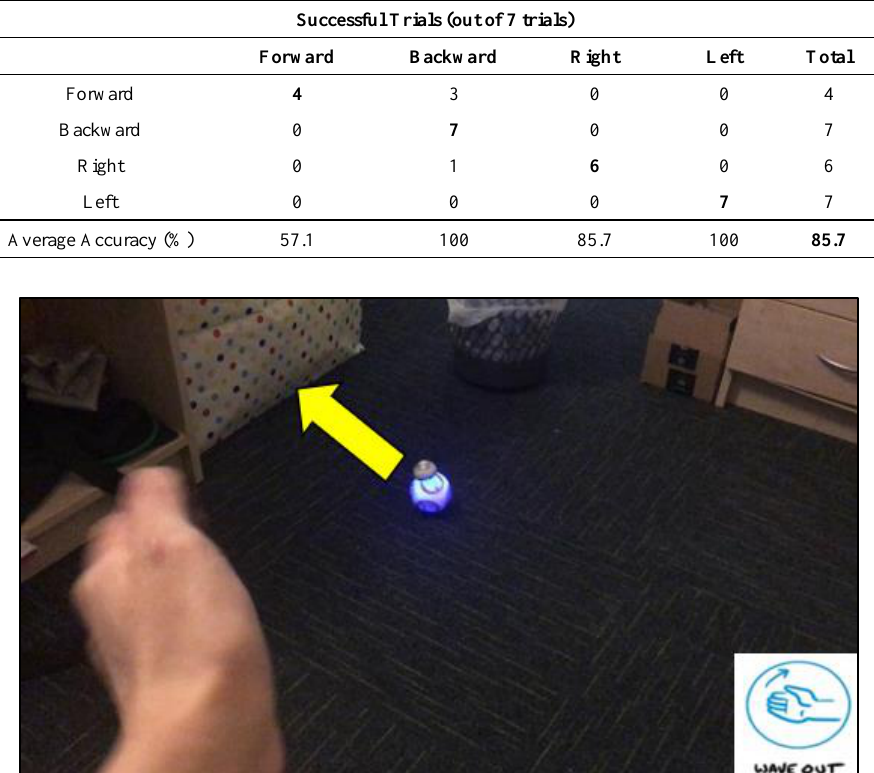
Figure 8. Wave Out gesture activates Left Motion of the